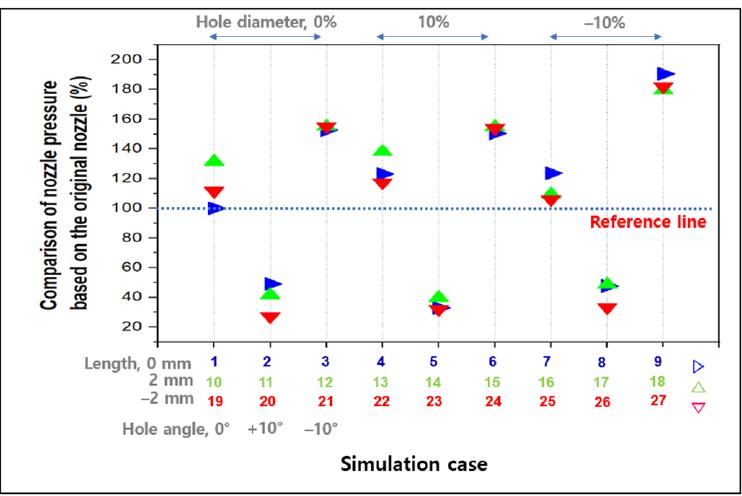
Figure 9. Comparison of nozzle pressure based on the original nozzle. The pressure generated at the inner wall in the lower part of the nozzle increased from 110% to 150% as the nozzle hole pipe angle was adjusted by 10%, 0%, and − 10% under the condition that the nozzle length and hole pipe diameter were the